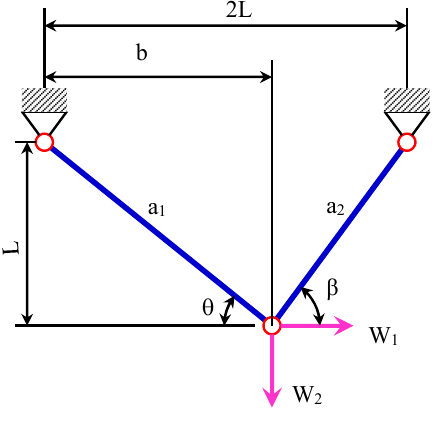
Figure A2. Two-bar